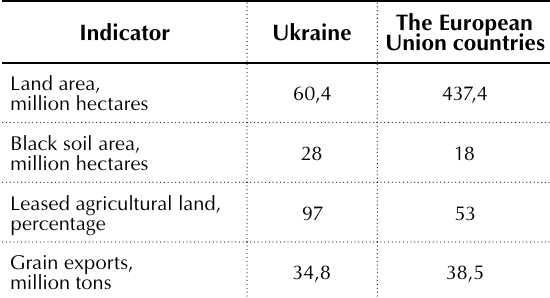
Table 1. Comparative characteristics of land use in European countries and Ukraine